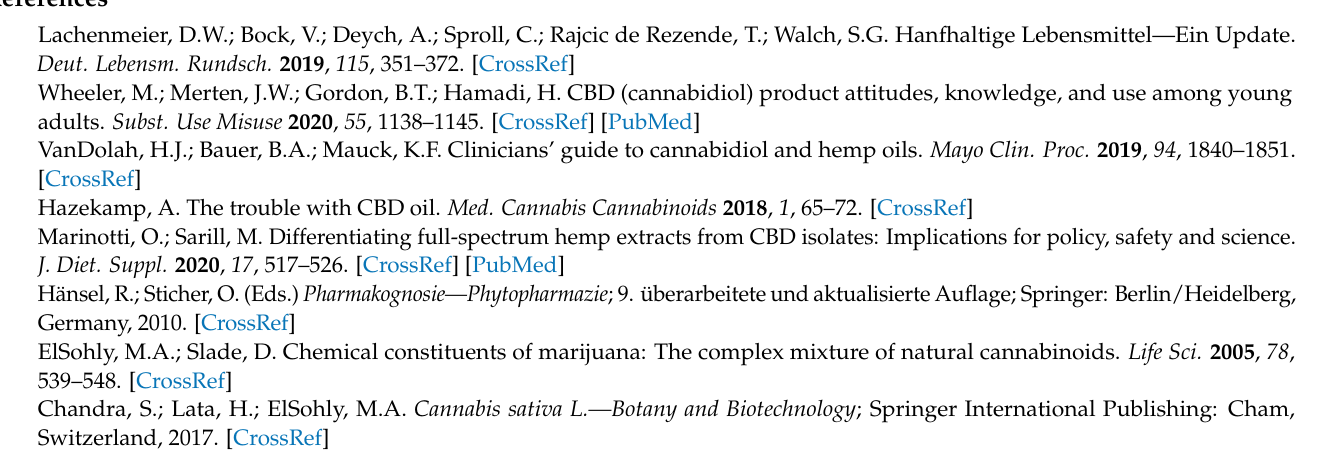
tion, Table S6: ∆ 9-tetrahydrocannabinol calibration, Table S7: ∆ 8-tetrahydrocannabinol calibration, Table S8: Assignment of the 1H NMR signals of cannabidiol and cannabidiolic acid, Table S9: As- signment of the 1H NMR signals of ∆ 9-tetrahydrocannabinol ( ∆ 9-THC), ∆ 9-tetrahydrocannabinolic Table S10: Assignment of the 1H NMR signals of cannabigerol and cannabinol, Table S11: Cali- bration data of the investigated cannabinoid signals, Table S12: Recoveries of the cannabinoids in [%], Table S13: Recovery in [%] of cannabidiol (CBD) determined from calibration without matrix, Figure S1: 1H NMR spectra of cannabidiol in (A) deuterated chloroform (CDCl3) and (B) deuterated methanol (CD3OD), Figure S2: 1H NMR spectra of a CBD oil in CDCl3 recorded with different suppression programs, Figure S3: Linear fit of NMR and LC-MS/MS results of all samples with NMR results above the